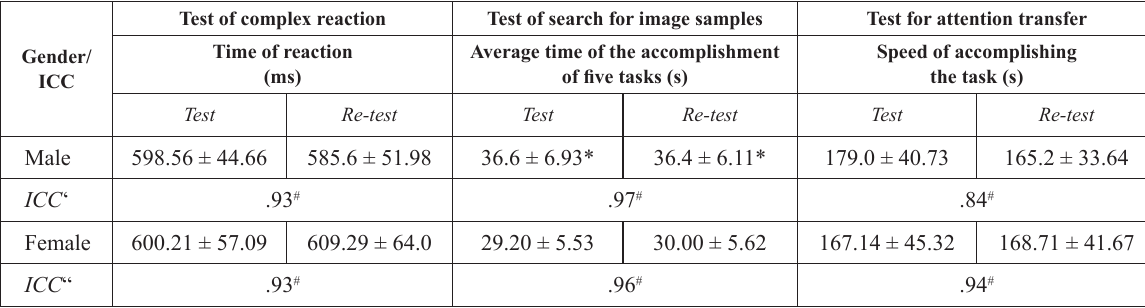
Table 2. Results of the reliability assessment of attention tests for both genders